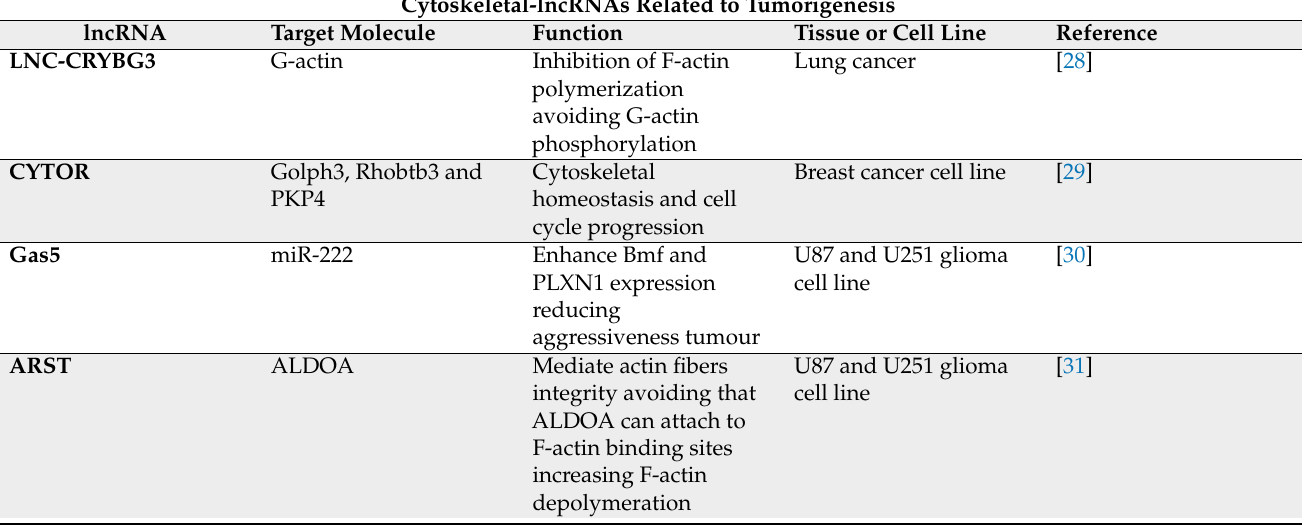
Table 1. Summary of lncRNAs related to cytoskeleton architecture and their impact on tumorigenesis as well as on other